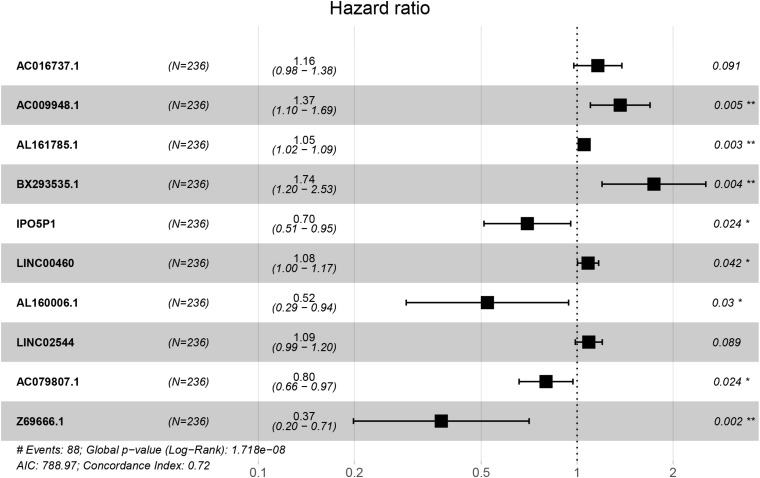
Forest plot of the prognostic value of the hypoxia-related lncRNAs.